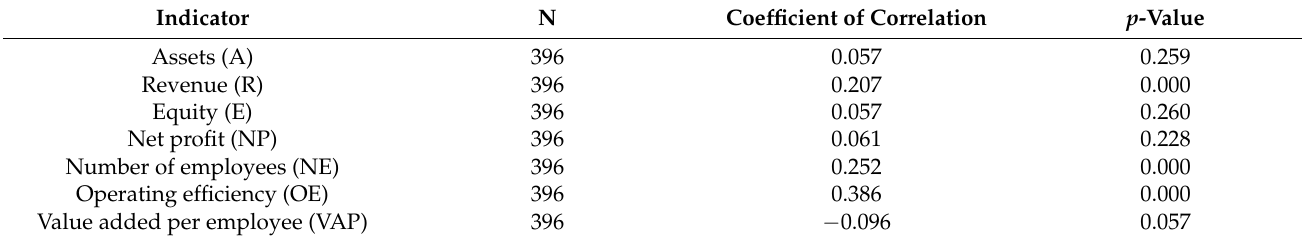
Table 4. Correlation coefficients for the economic and financial indicators indices in the two financial